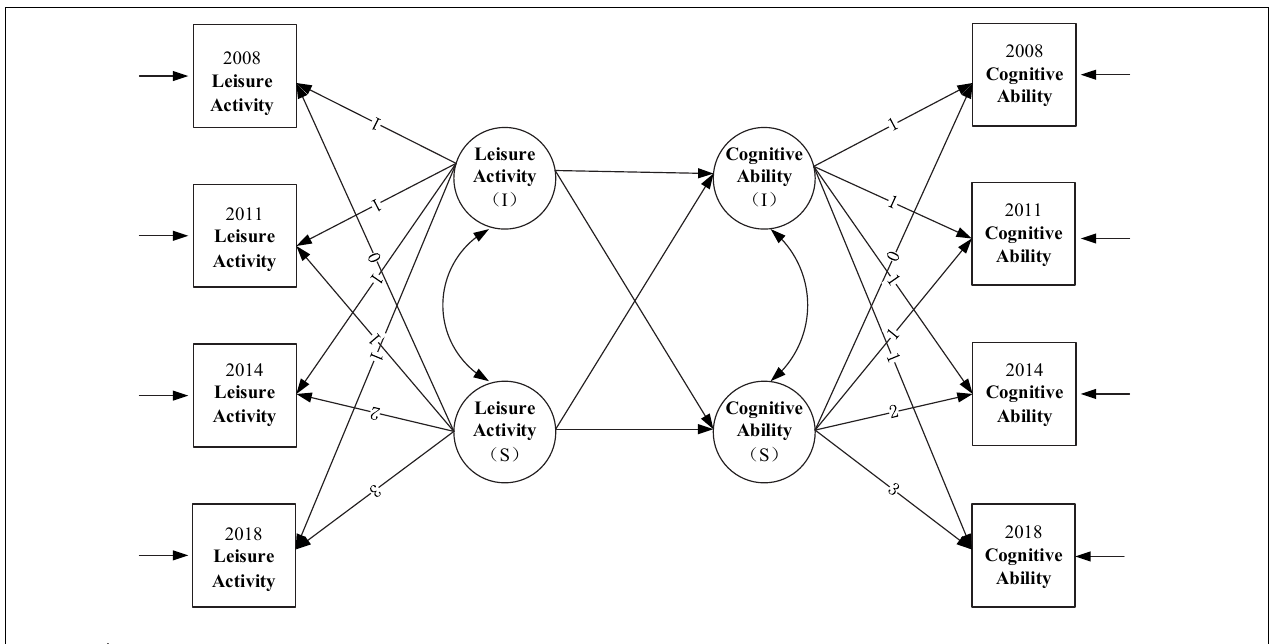
FIGURE 9 | Parallel development model. I denote intercept; S denote slope.